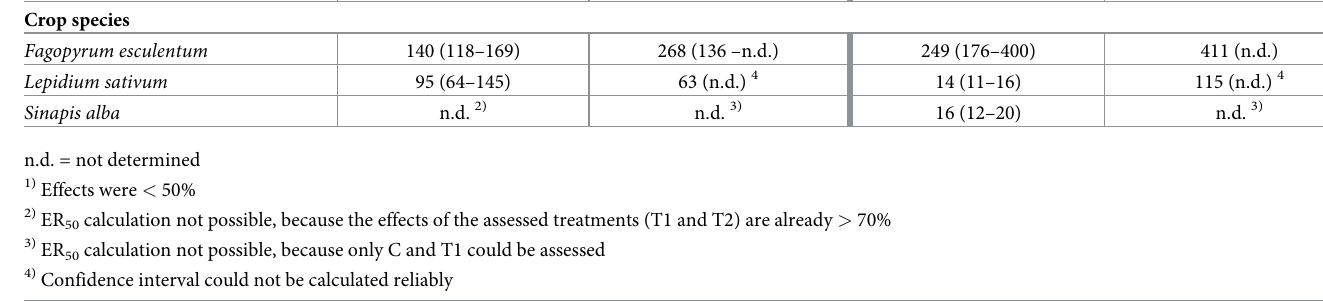
lium pratense showed a lower ER 50 at growth stage 21 DAA than at BBCH 89. For Agrostemma githago and Coriandrum sativum the ER 50 was similar at both growth stages. The NOER values (Table 5) for the vegetative endpoints plant height and biomass at the vegetative growth stage (21DAA) and generative growth stage (BBCH 89) showed a similar pattern regarding sensitivity as the ER values. 50